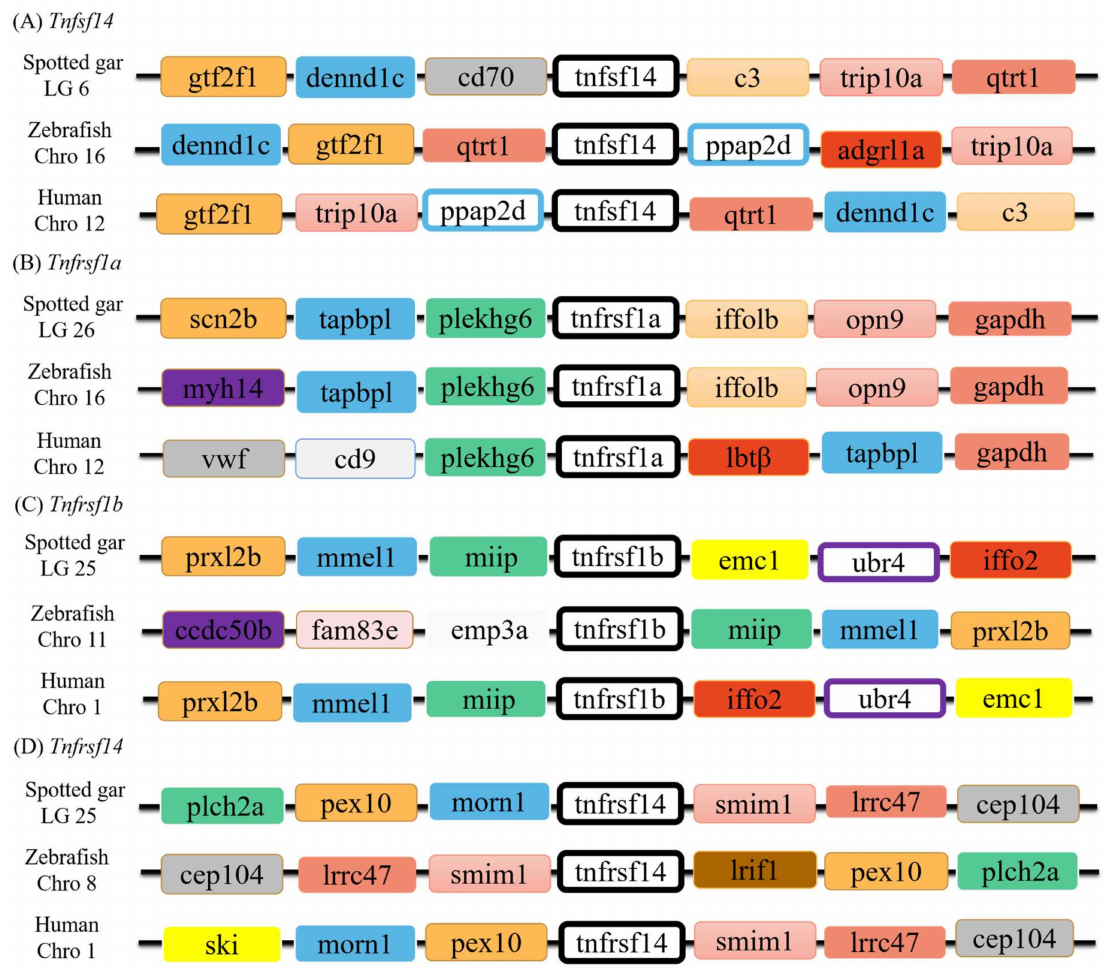
Figure 3. Gene synteny of tnfsf14 ( A ), tnfrsf1a ( B ), tnfrsf1b ( C ) and tnfrsf14 ( D ). The synteny information for human, zebrafish and spotted gar genes was obtained from the NCBI database. Acronyms of genes are adopted from the NCBI